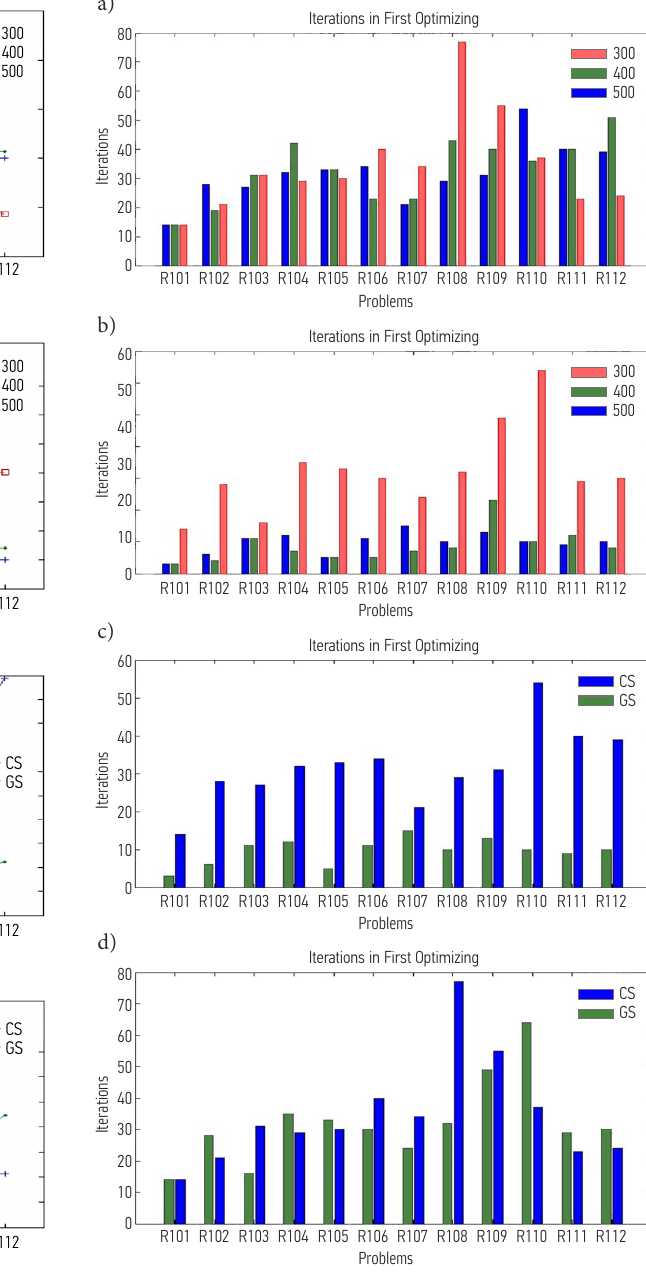
Fig. 2. Comparison of total number of path searching under different condition and searching number: a – total number of vehicle under CS; b – total number of vehicle under GS; c – vehicle number under searching time 500; d – vehicle